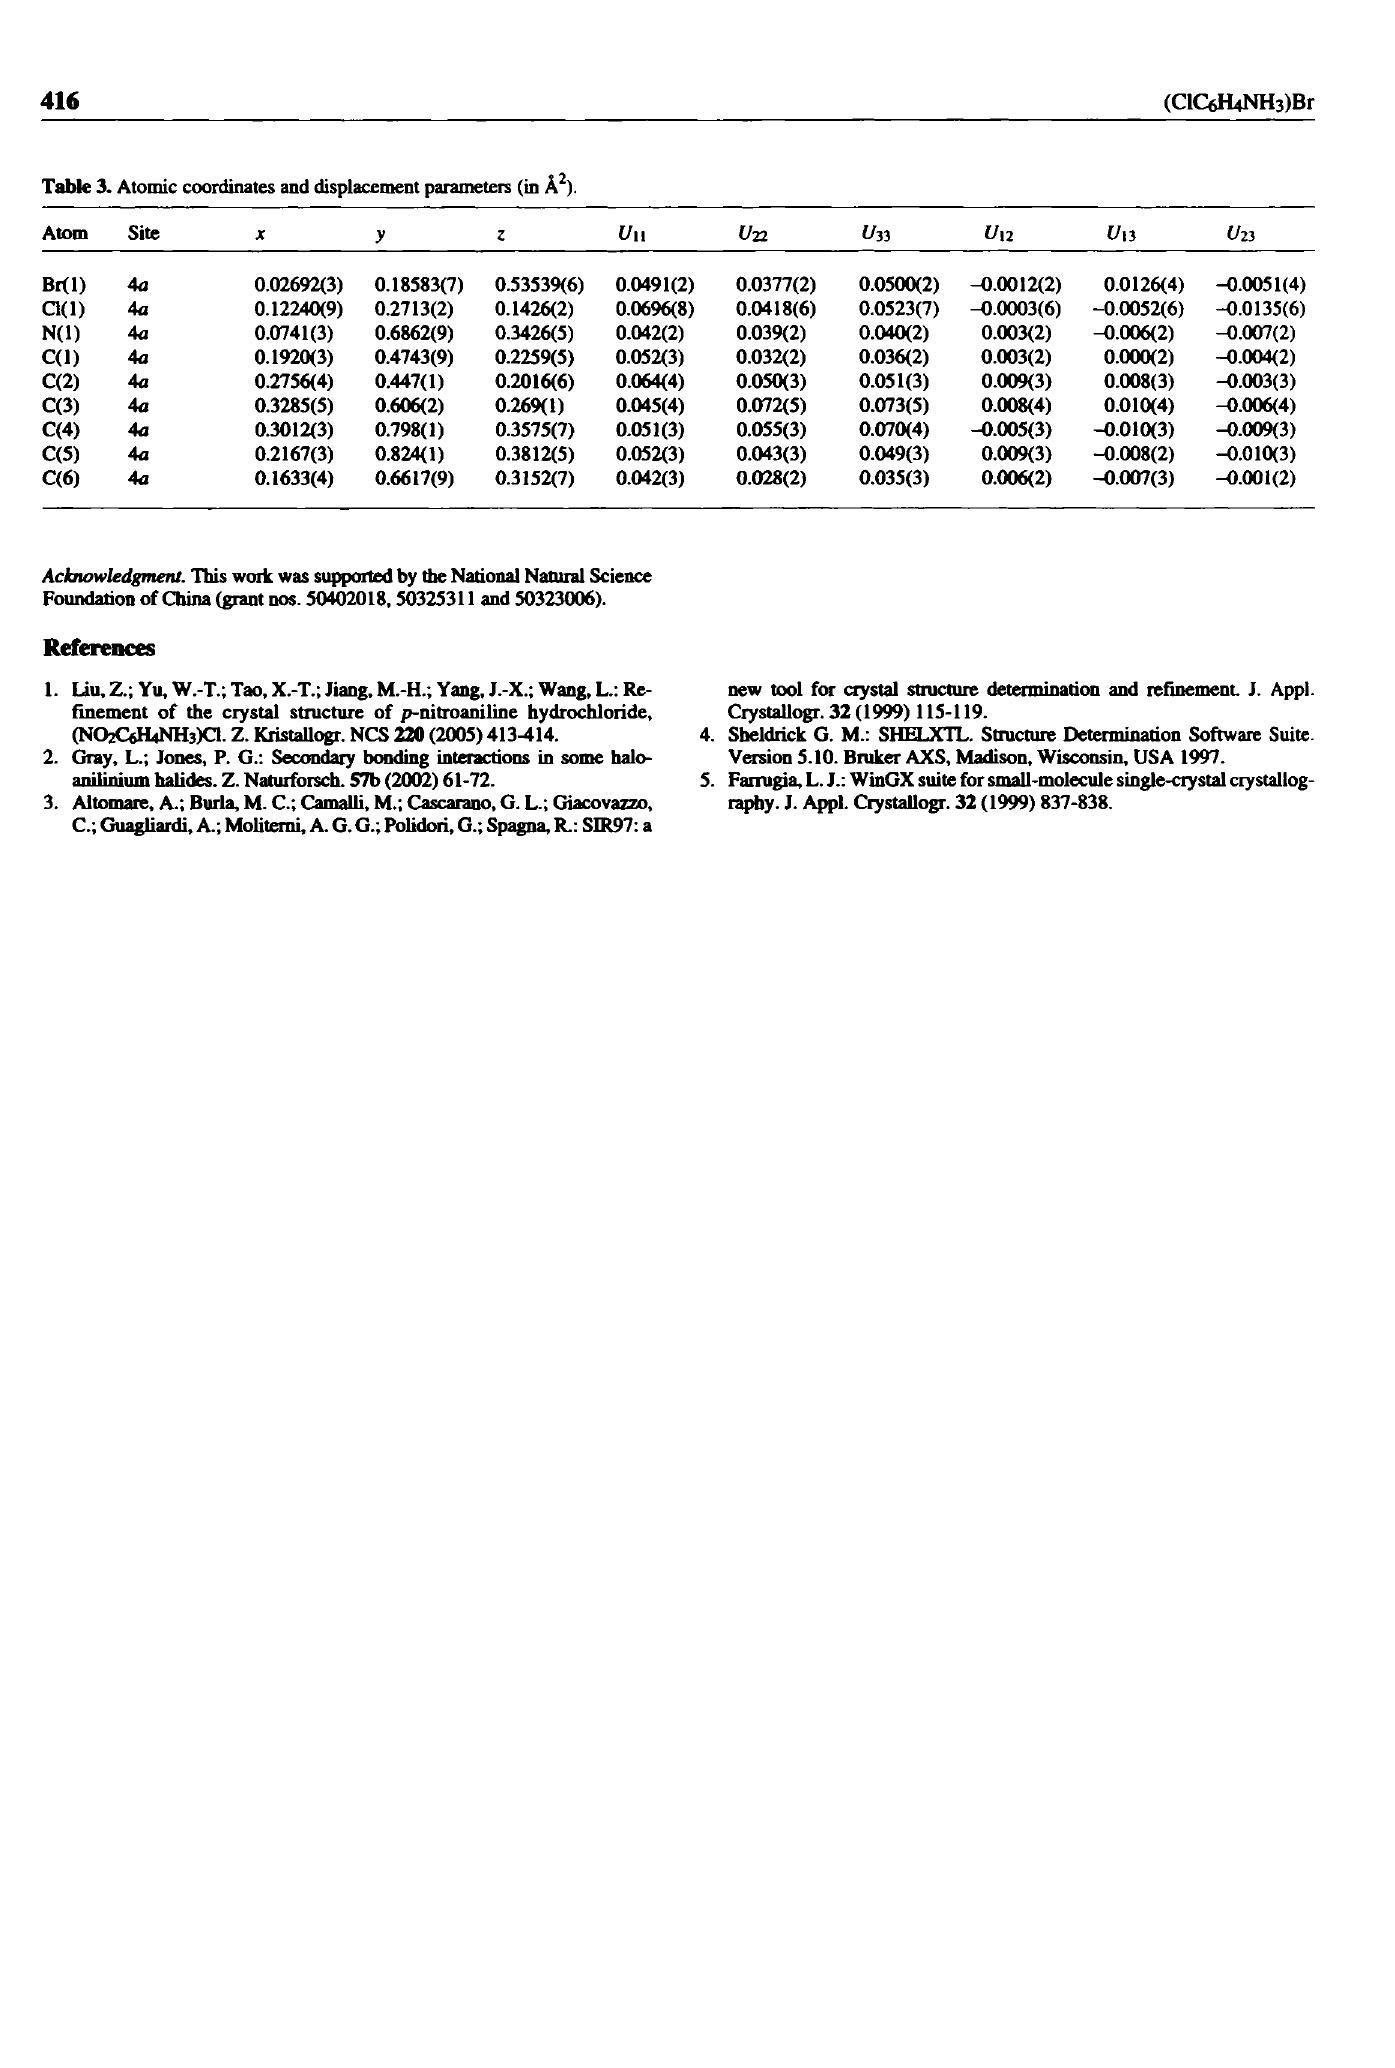
Table 3. Atomic coordinates and displacement parameters (in Ä 2